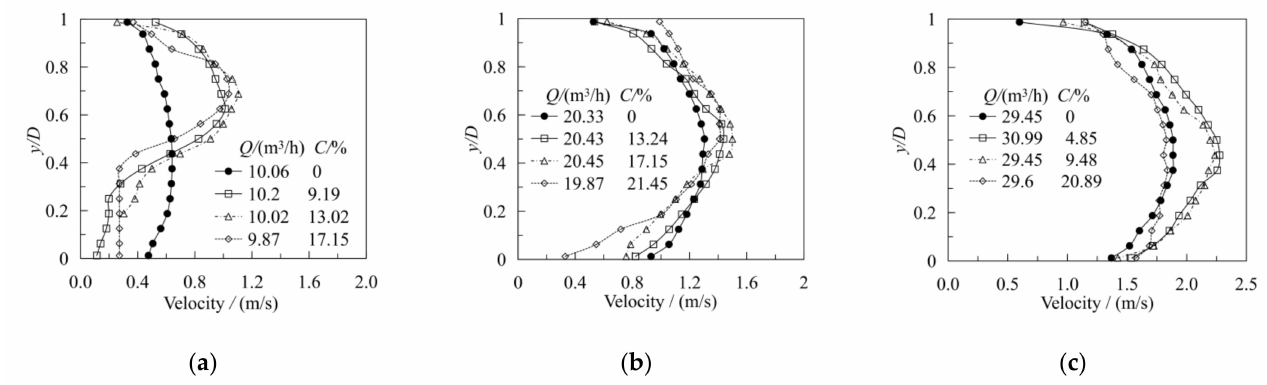
Figure 7. Vertical distribution of observed velocity for different flow rates: ( a ) Q = 9.87–10.2 m 3 /h; ( b ) Q = 19.87–20.45 m 3 /h; and ( c ) Q = 29.45–30.99 m 3